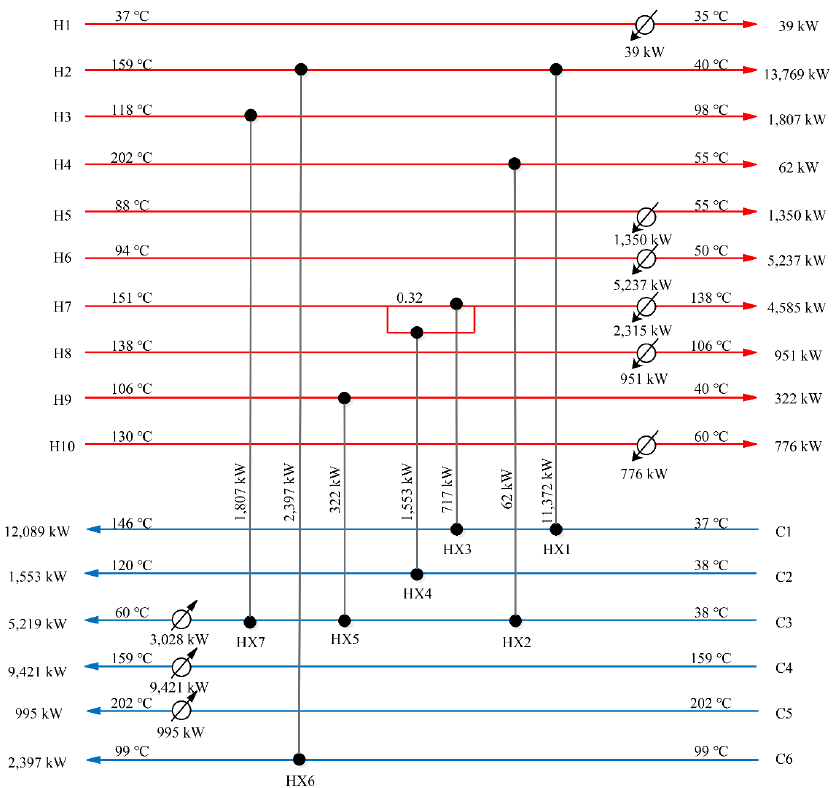
Figure 9. Final heat exchange network structure. The red line represents the hot streams for heating, the blue line represents the cold streams for cooling, and the solid circle represents the heat exchanger. The arrow indicates the direction of heat transfer.